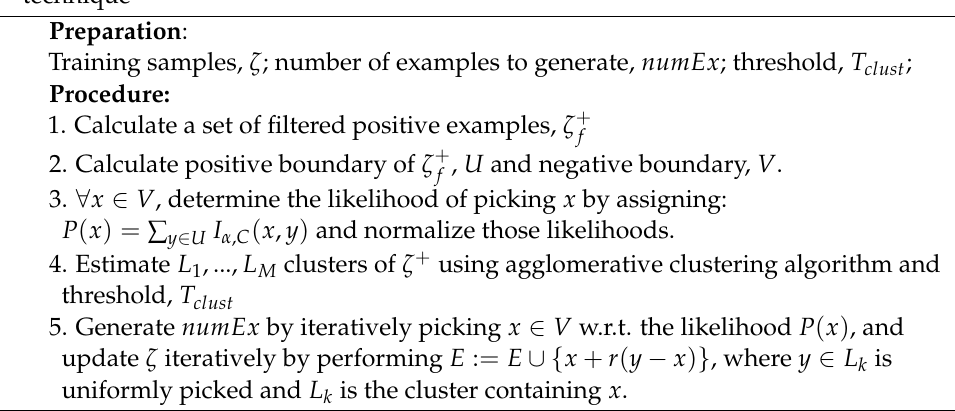
Algorithm 1: General procedure of majority weighted minority